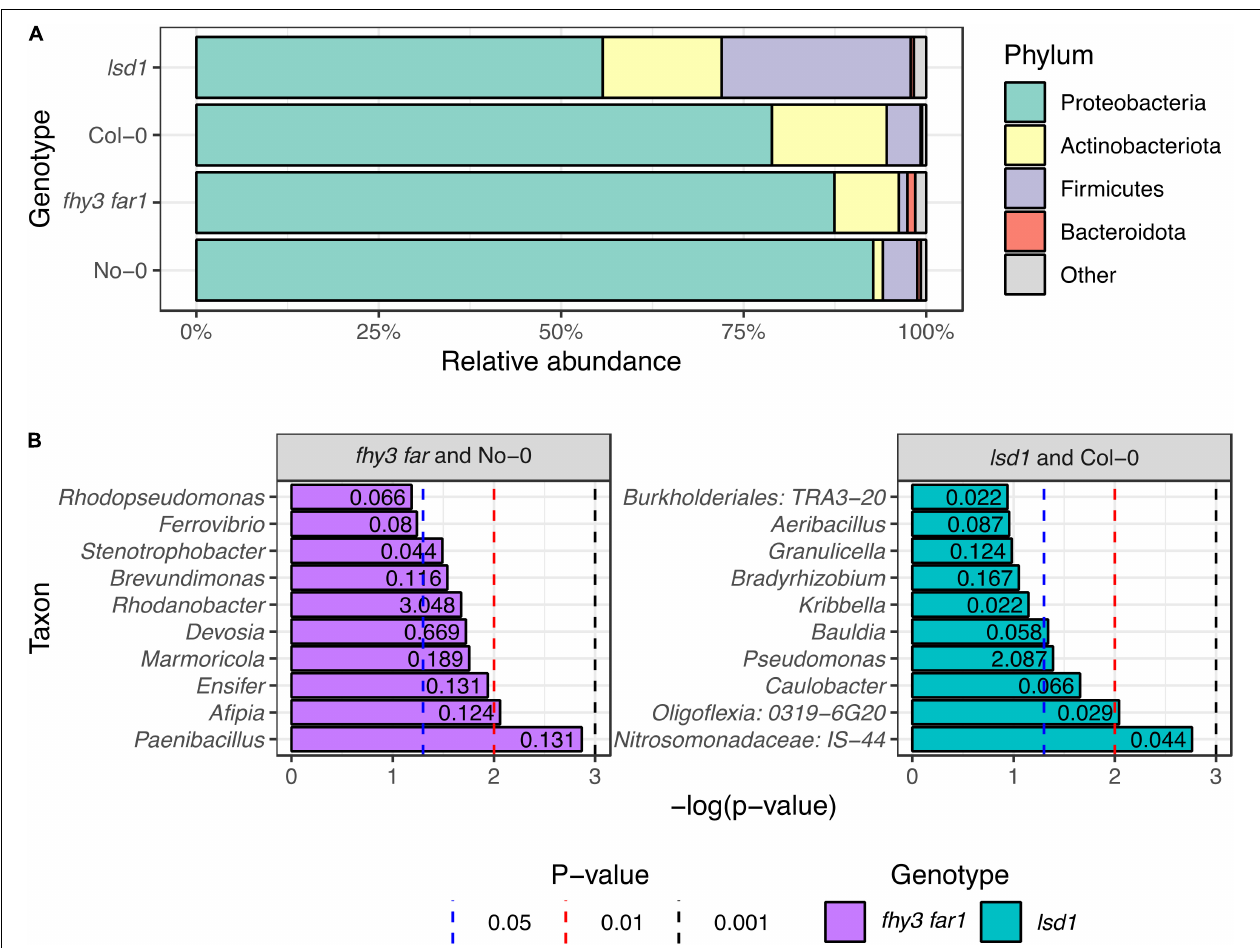
FIGURE 2 | Phylotype abundances in phyllospheric bacterial communities in wild type and salicylic acid signaling mutants. (A) Relative abundances of classified bacterial phyla across all four genotypes. Classification of 16S rRNA sequences was carried out using the SILVA database (v.138) in mothur (v.1.44.3) (Schloss et al., 2009; Quast et al., 2013). (B) Taxa identified as differentially abundant in fhy3 far1 and lsd1 samples compared to their WT background ecotypes (No-0 and Col-0, respectively). Numbers presented on barcharts represent the relative abundance of the taxon (%). Statistical analysis carried out using the Metastats algorithm in mothur (v.1.44.3) (Schloss et al., 2009; White et al., 2009) on subsampled data. Sequences were isolated from aerial tissue 35 DAS ( n = 3 for all